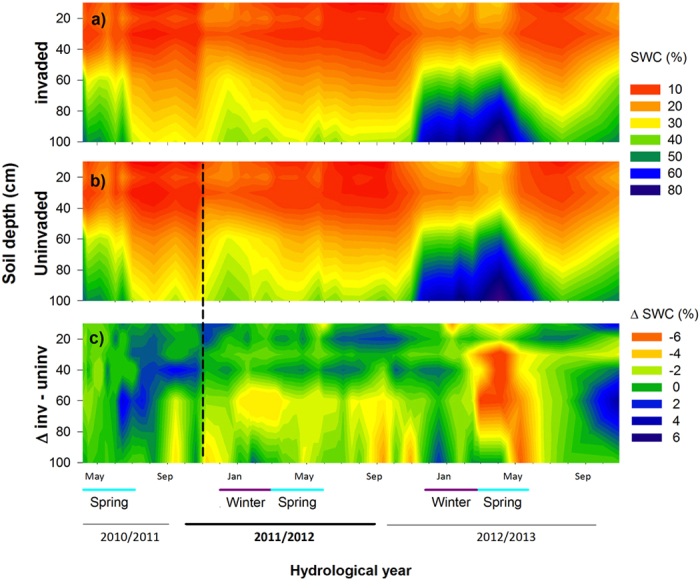
Changes in volumetric soil water content within the soil profile in invaded and uninvaded stands with time.Volumetric soil water content (SWC %; 4 tubes per stand, six stands; n = 3) at 5 depths (20, 40, 60, 80, 100 cm) from 2011–2013 at (a), Quercus suber stands invaded by shrubs and, (b) Q. suber stands where invading shrubs were removed in November 2011 (dashed line). (c) Difference (ΔSWC) in volumetric soil water content between invaded and uninvaded stands, with orange (negative differences) indicating drier and blue (positive differences) wetter soil at invaded stands. Multivariate analysis of variance (MANOVA) was used to test SWC differences along time after shrubs were cut, considering site and soil depth as fixed factors. Uninvaded stands had higher SWC than invaded stands (Wilks Lambda = 0.492, F29,66 = 2.352, p < 0.01; η2p = 0.508). The interaction between treatment x time was significant (Wilks Lambda = 0.512, F28,67 = 2.284, p < 0.01; η2p = 0.488). There was a significant interaction time x soil depth (Wilks Lambda = 0.001, F140,335.83 = 7.91, p < 0.001; η2p = 0.763). The interaction time x treatments x soil depth was not significant (Wilks Lambda = 0.141, F140,335.83 = 1.170, p > 0.05; η2p = 0.324).